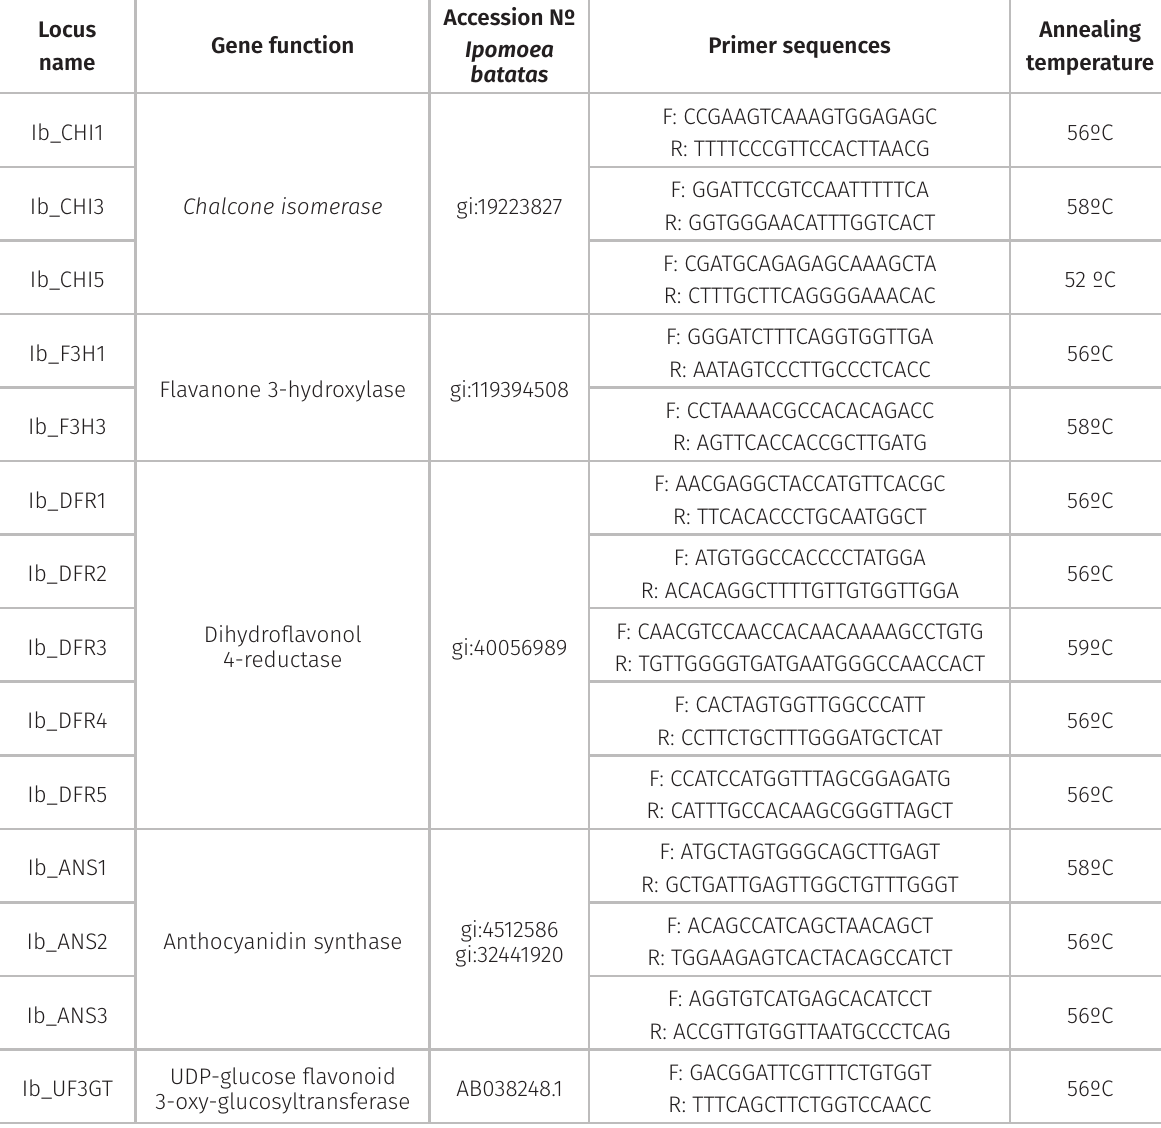
Table III. List of primers of ILP-GC markers developed for anthocyanins biosynthesis pathway in sweet potato: locus name, corresponding gene, Genbank accession number, primer sequences, and annealing temperature.